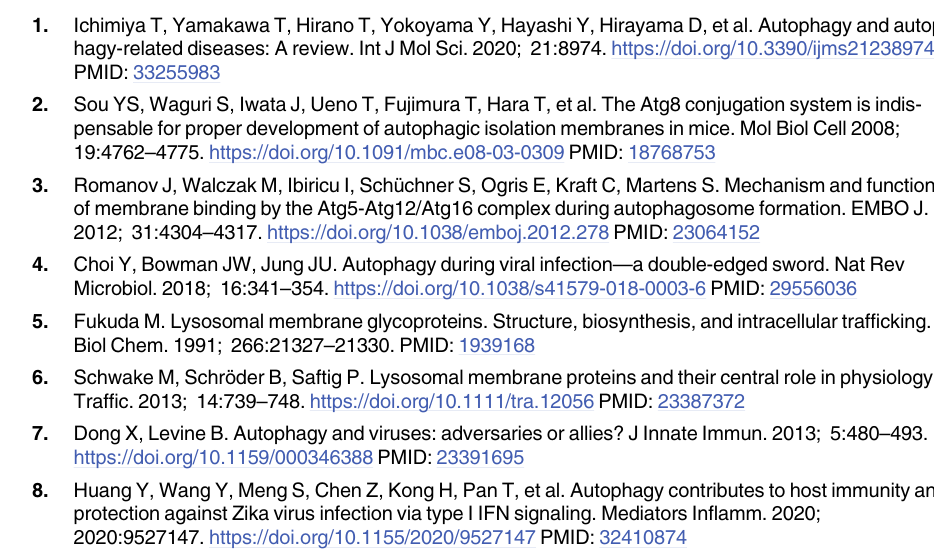
S1 Table. Primers used in this